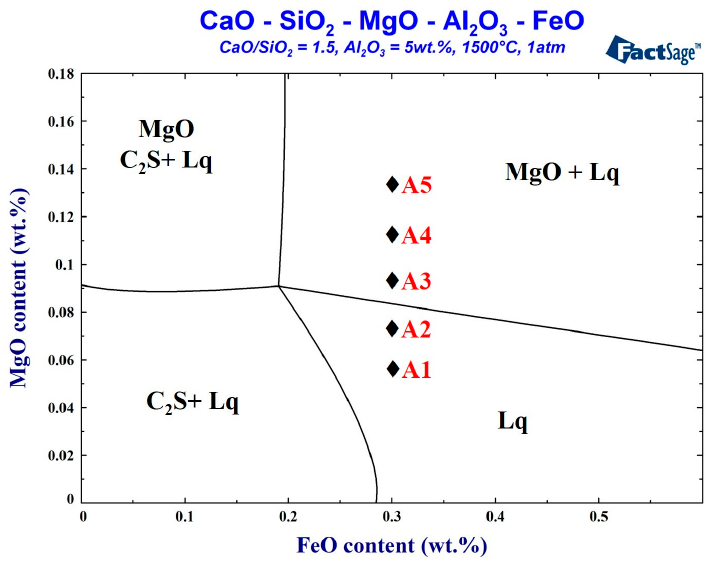
Figure 1. Factsage simulated phase diagram of foaming slag at 1500 °C. Table 1. Foaming slag compositions of this study.